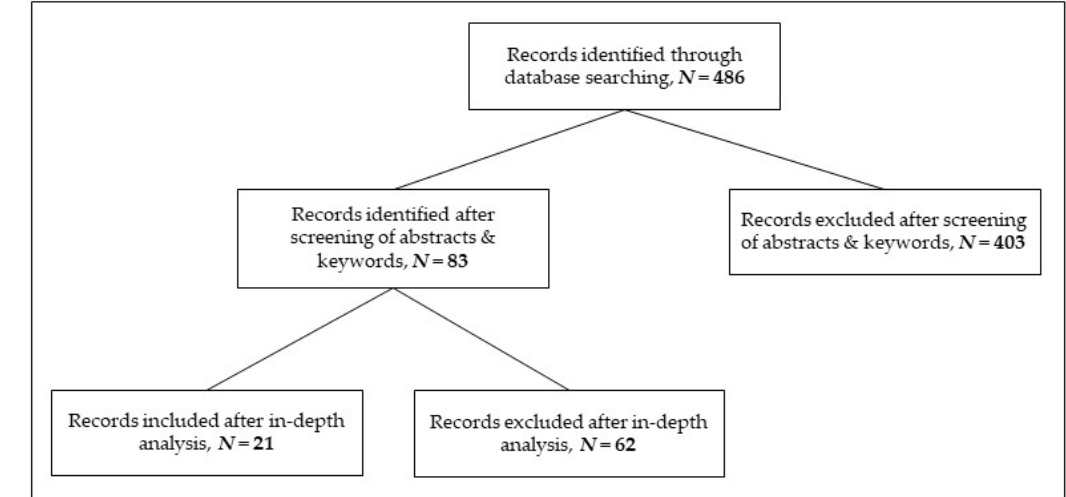
Figure 1. Inclusion and exclusion of manuscripts.